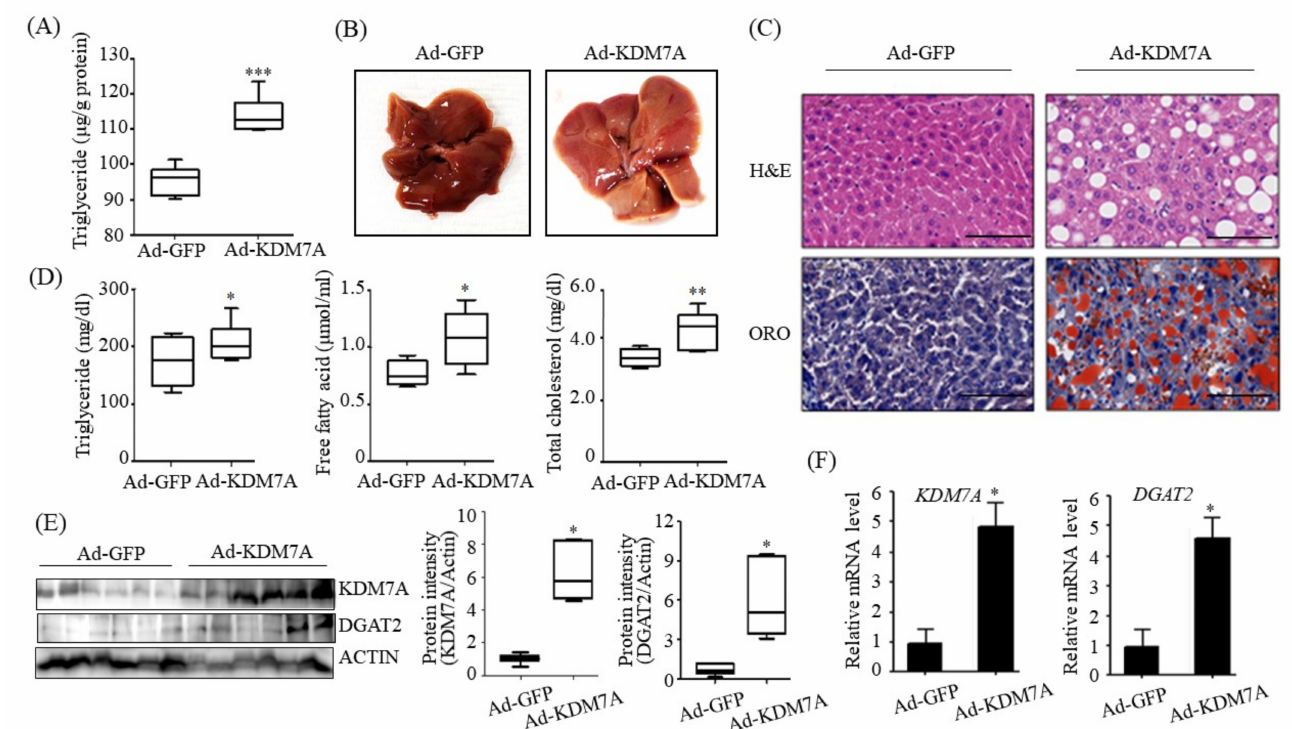
Figure 5. Adenovirus-mediated KDM7A overexpression induces hepatic steatosis in vivo. C57BL/6 mice (8 weeks old) were injected with adenovirus Ad-GFP or Ad-KDM7A. After injection, Ad-injected mice were fed a ND for 4 weeks. ( A ) Quantitation of hepatic TG. Hepatic TG levels were measured using a TG assay kit. ( B ) Representative photograph of liver. ( C ) Representative H&E and ORO staining images (scale bar = 50 µ m). ( D ) Serum levels of TG, free fatty acid and total cholesterol. ( E ) Protein levels of KDM7A and DGAT2 were determined by Western blotting. Quantifications were performed using ImageJ from 6 mice. ( F ) mRNA levels of KDM7A and DGAT2 were measured by qPCR. Data are presented as the mean ± SD from 6 mice per group. * p < 0.05, ** p < 0.01, *** p < 0.001 vs. control mice